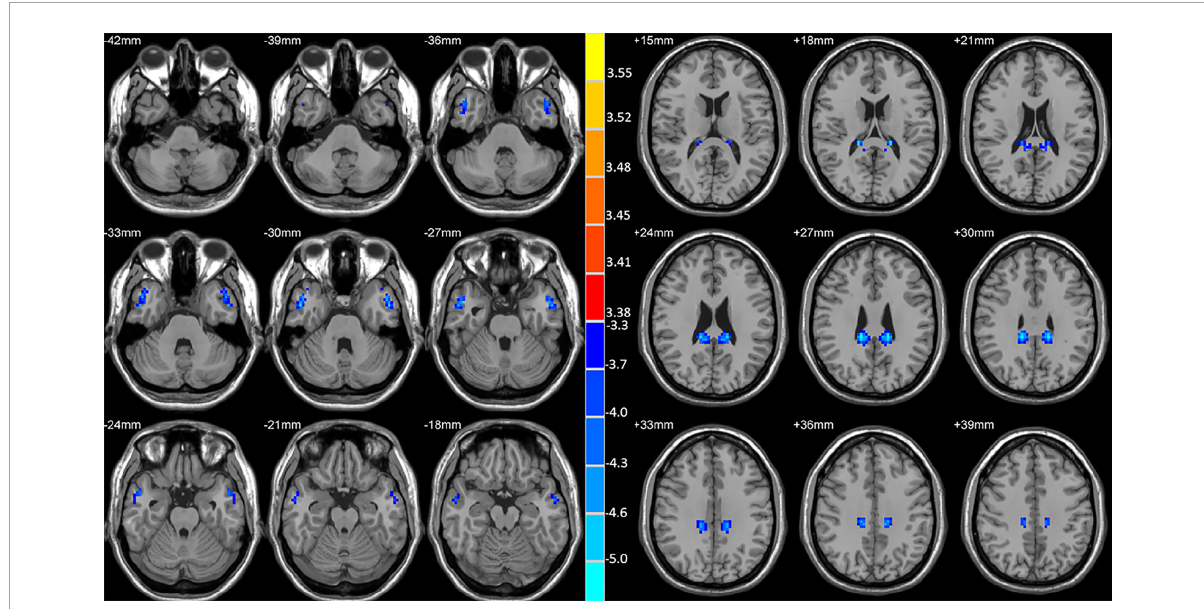
FIGURE1 Statistical maps showing VMHC differences between the subject groups. Blue denotes lower VMHC, red denotes higher VMHC, and the color bar indicates the T -values from two-sample t -tests.